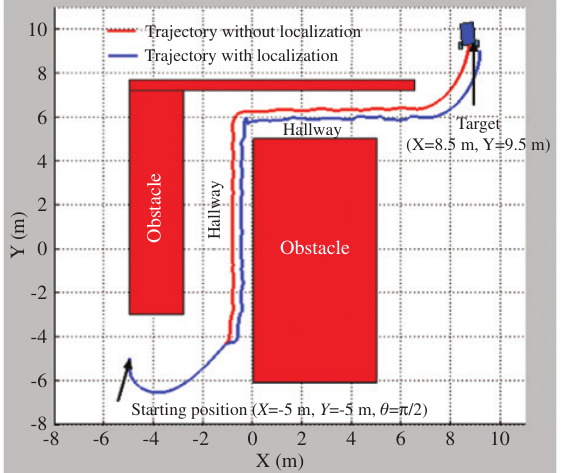
Figure 12: Trajectory Obtained by the EKF in an Environment with